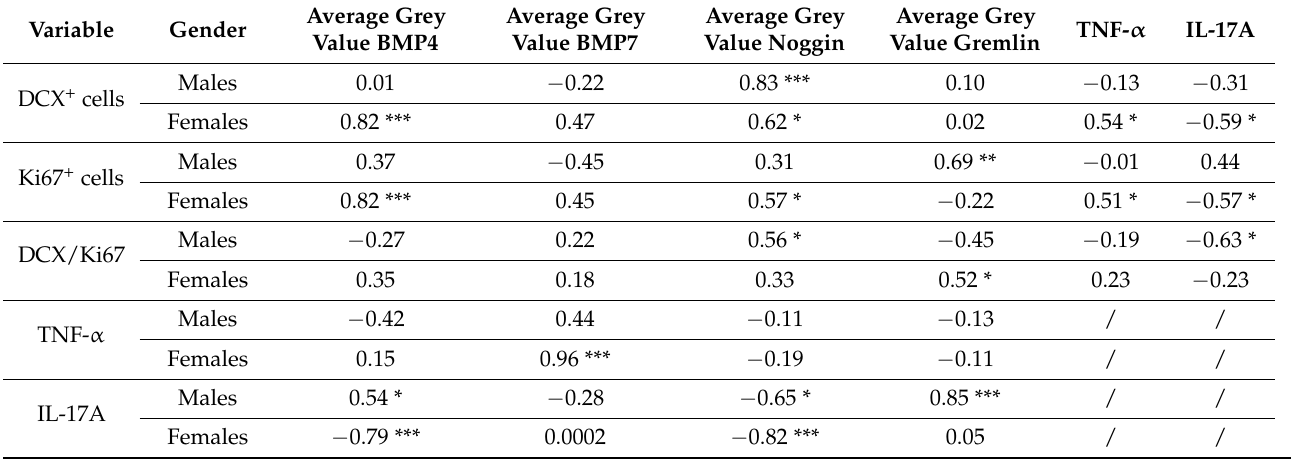
Figure 1. Clinical course. The clinical course in the male (n = 45) and female (n = 45) rat groups. Values are presented as mean ± SD (Mann–Whitney U test) using PIA scores of each animal for every day. Table 1. Pearson’s correlation between hippocampal neurogenesis, hippocampal/dentate gyrus expressions of BMPs, Noggin, Gremlin, and IL-17A and TNF- α levels in